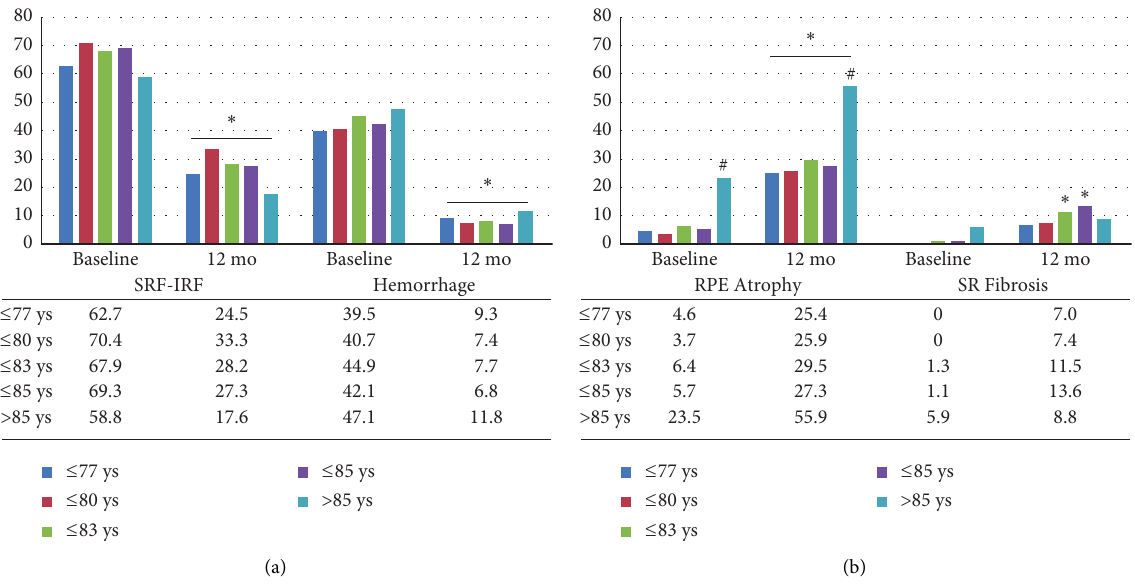
Figure 4: Presence of retinal findings during the period of study by age subgroups. (a) Changes in percentages of eyes with subretinal fluid (SFR), intraretinal fluid (IRF), and hemorrhages and (b) percentage of eyes presenting retinal pigment epithelium (RPE) atrophy and subretinal (SR) fibrosis, at baseline, after the loading dose (LD) and at 12 months (12mo), were significant ( ∗ ). Percentage of eyes in the subgroup of patients with more than 85 years presented significant (#) RPE atrophy at the baseline and at final